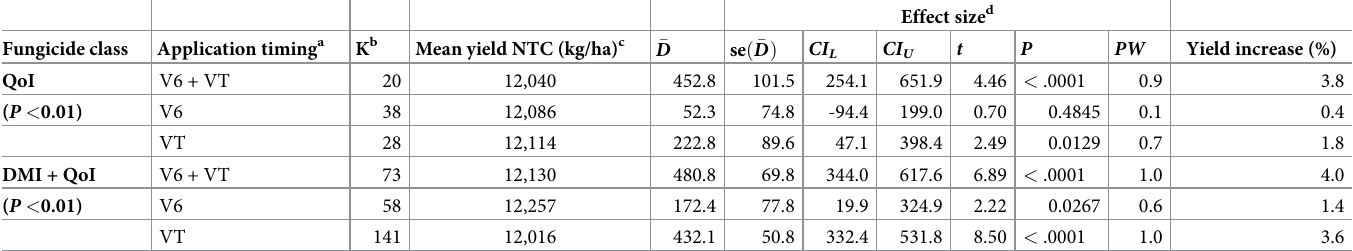
Table 4. Influence of application timing on yield response to fungicide from quinone outside inhibitors (QoI), and a premix of demethylation inhibitors (DMI) and QoI fungicide classes with the corresponding statistics based on mixed-effect meta-analysis of trials conducted in 12 U.S. states and Ontario, Canada in 2014 and